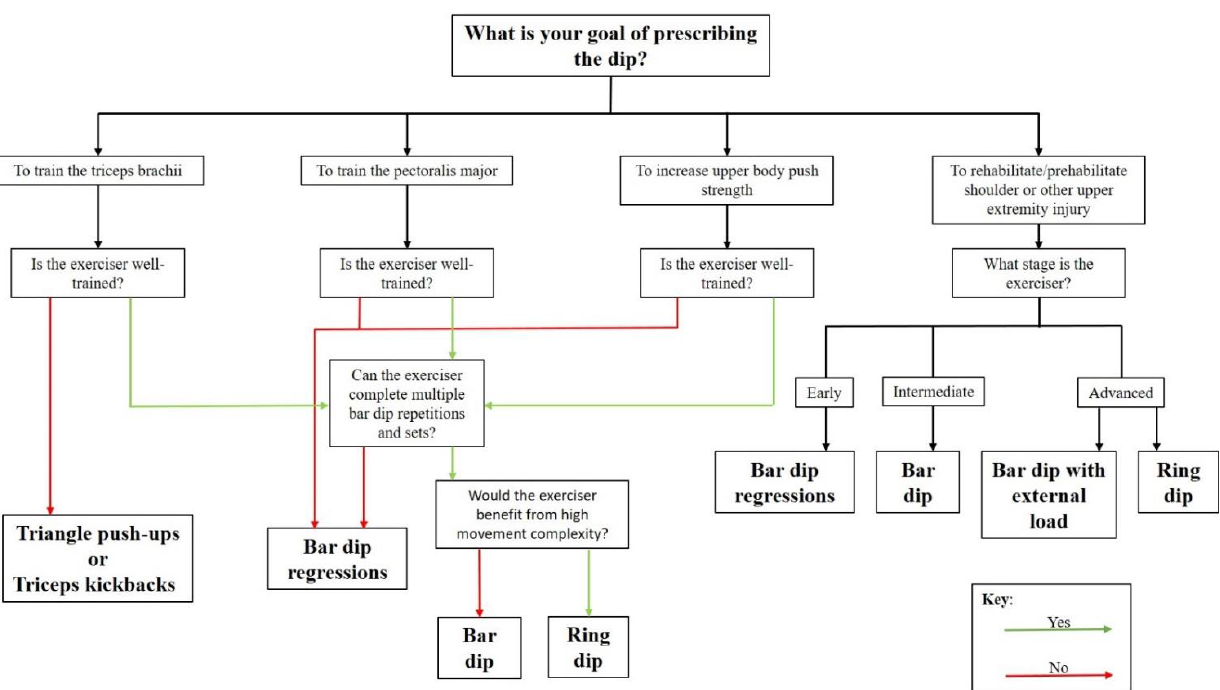
Figure 6. A flow chart identifying which dip variations should be prescribed for four common rea-